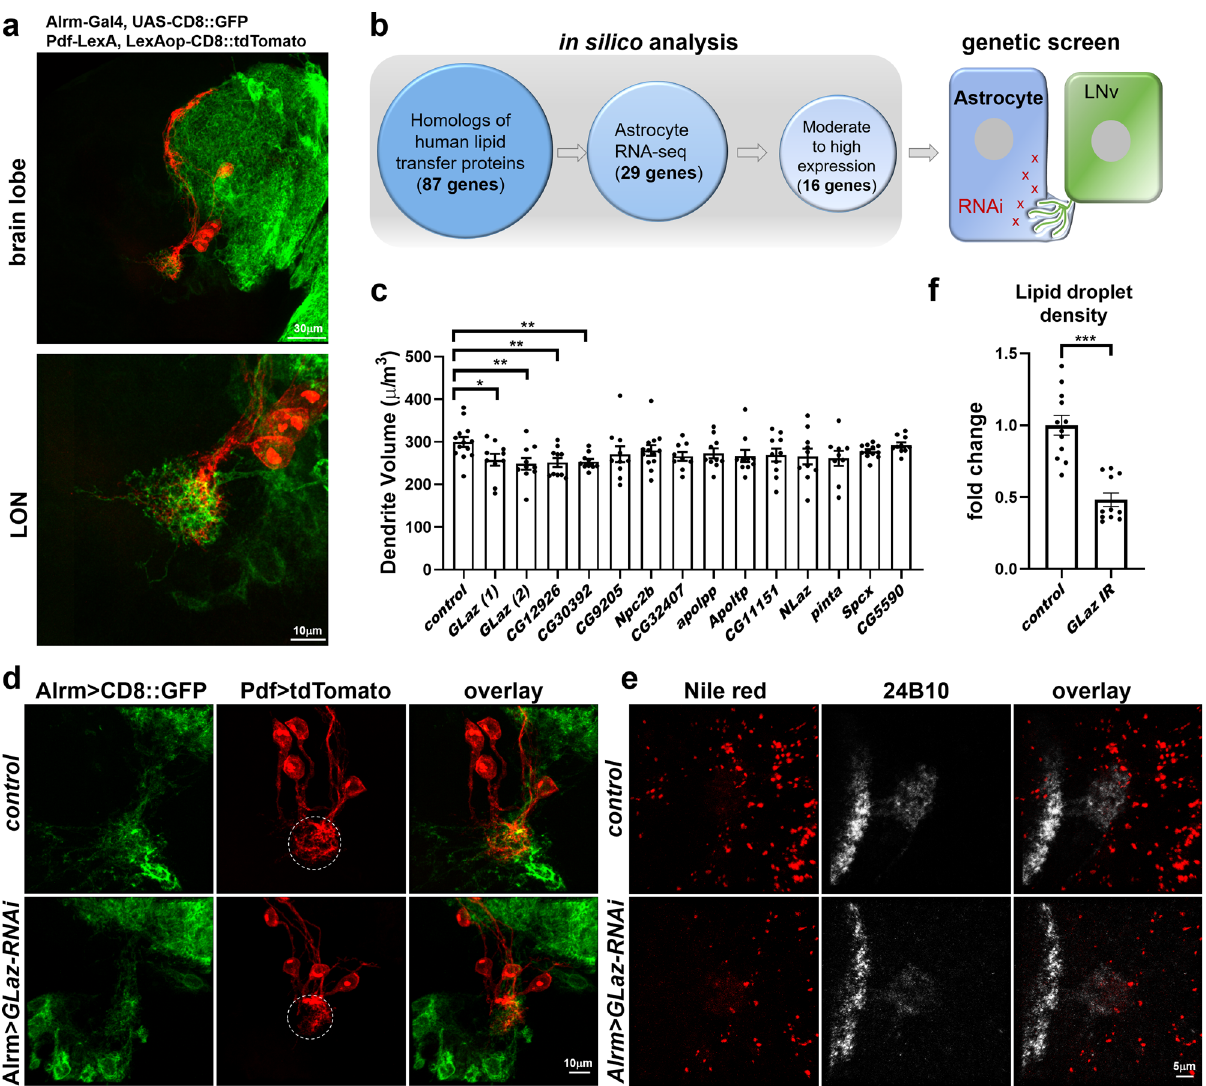
Fig. 6 Genetic screens reveal the function of astrocyte-derived GLaz in dendrite development and lipid homeostasis. a Astrocyte processes (labeled by Alrm-Gal4 driving CD8::GFP, green) and LNv dendrites (labeled by Pdf-lexA driving LexAop-tdTomato, red) show close interactions with the LON (observed in at least 10 brains). b A schematic representation of analyses performed to identify potential astrocyte-derived ligands for LpR1-short. Candidate lipoproteins were found by combined bioinformatic analyses and genetic screens of fl y homologs of human lipid transfer proteins enriched in astrocytes. Genetic screens were performed using astrocyte-speci fi c RNAi knock-down of candidate genes and subsequent quanti fi cation of LNv dendrite volume. c Quanti fi cations of LNv dendrite volume. Transgenic RNAi knock-down of lipid transport proteins GLaz, CG12926, and CG30392 in astrocytes leads to signi fi cant LNv dendrite volume reduction. Data are presented as mean values + / − SEM. Statistical signi fi cance was assessed by a two-tailed Student ’ s t -test comparing with the control sample. GLaz (1) : p = 0.0297, t = 2.333, df = 21; GLaz (2) : p = 0.0097, t = 2.846, df = 21; CG12926 : p = 0.0075, t = 2.956, df = 21; CG30392 : p = 0.0044, t = 3.194, df = 21; CG9205 : p = 0.1874, t = 1.363, df = 21; Npc2b : p = 0.2483, t = 1.183, df = 24; CG32407 : p = 0.0550, t = 2.038, df = 20; apolpp : p = 0.1263, t = 1.592, df = 21; Apoltp : p = 0.0831, t = 1.820, df = 21; CG11151 : p = 0.1164, t = 1.638, df = 21; NLaz : p = 0.1178, t = 1.631, df = 21; pinta : p = 0.0721, t = 1.899, df = 20; Spcx : p = 0.1057, t = 1.684, df = 23; CG5590 : p = 0.6180, t = 0.5062, df = 21. n = 13, 10, 10, 10, 10, 10, 13, 9, 10, 10, 10, 10, 9, 12, and 10 for control , GLaz (1) , GLaz (2) , CG12926 , CG30392 , CG9205 , Npc2b , CG32407 , apolpp , Apoltp , CG11151 , NLaz , pinta , Spcx , and CG5590 . n represents individual larval brain samples. * p < 0.05, ** p < 0.01. d Representative projected confocal images showing the reduced LNv dendrite volume (red) by knocking down GLaz in astrocytes (green) (repeated in at least 10 brains). e – f Astrocyte-derived GLaz regulates lipid droplet density in LON. Representative projected confocal images ( e ) and quanti fi cations ( f ) showing that lipid droplet density in LON is reduced when GLaz expression is knocked down in astrocytes. Data in f are presented as mean values + / − SEM. Statistical signi fi cance was assessed by a two-tailed Student ’ s t -test. p < 0.0001, t = 6.178, df = 21. n = 12 and 11 for control and GLaz IR . n represents individual larval brain samples. *** p < using anti-GFP antibody-conjugated magnetic beads to pull down LpR1-short-GFP or LpR1-long-GFP, followed by incubation with the brain extract containing GLaz-HA. Consistently, this set of co-IP experiments showed that GLaz-HA is pulled down by, and thus binds speci fi cally to, LpR1-short-GFP, but not LpR1-long- GFP (Supplementary Fig. 9b).